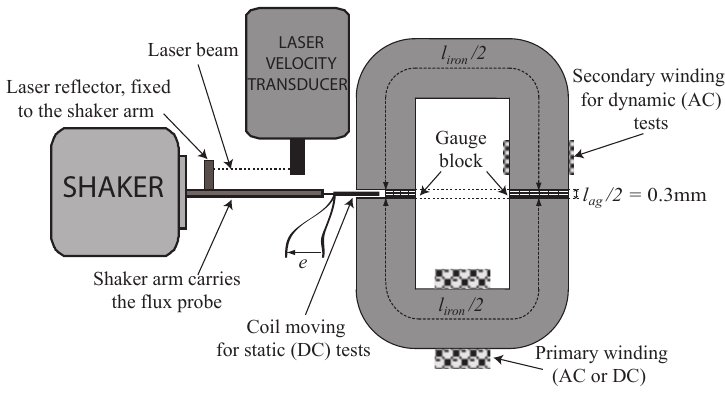
Figure 2. Test bench for static